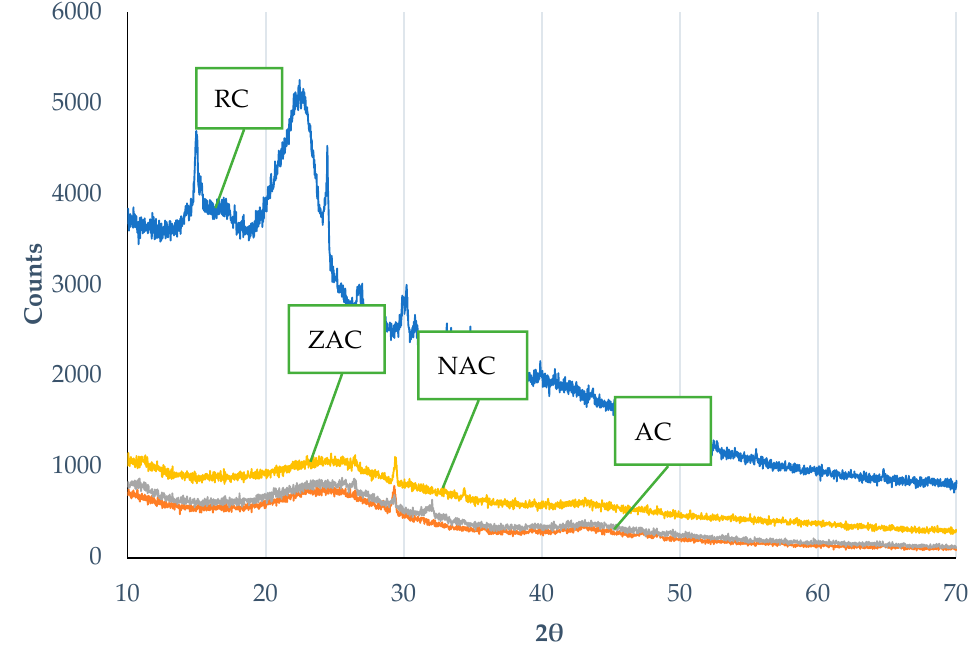
Figure 4. The X-ray diffractogram for adsorbent samples.